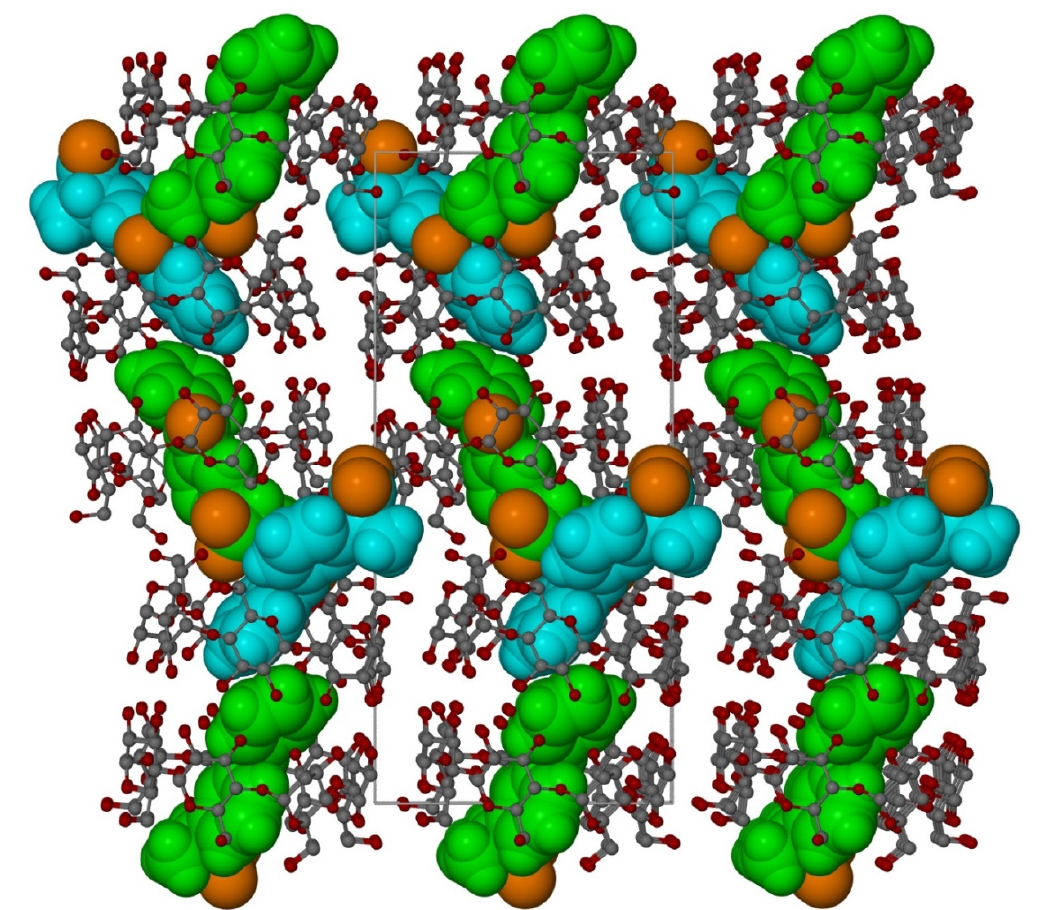
Figure 6. Autostereogram of the crystal structure in c-direction. Only one KP conformation for every blue and green molecule is shown.